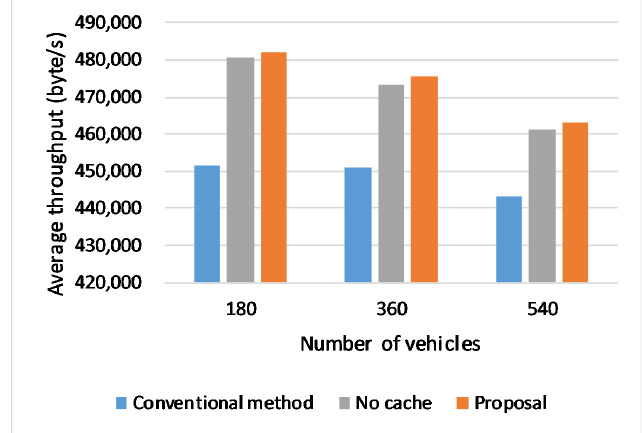
Figure 11. Throughput in different numbers of